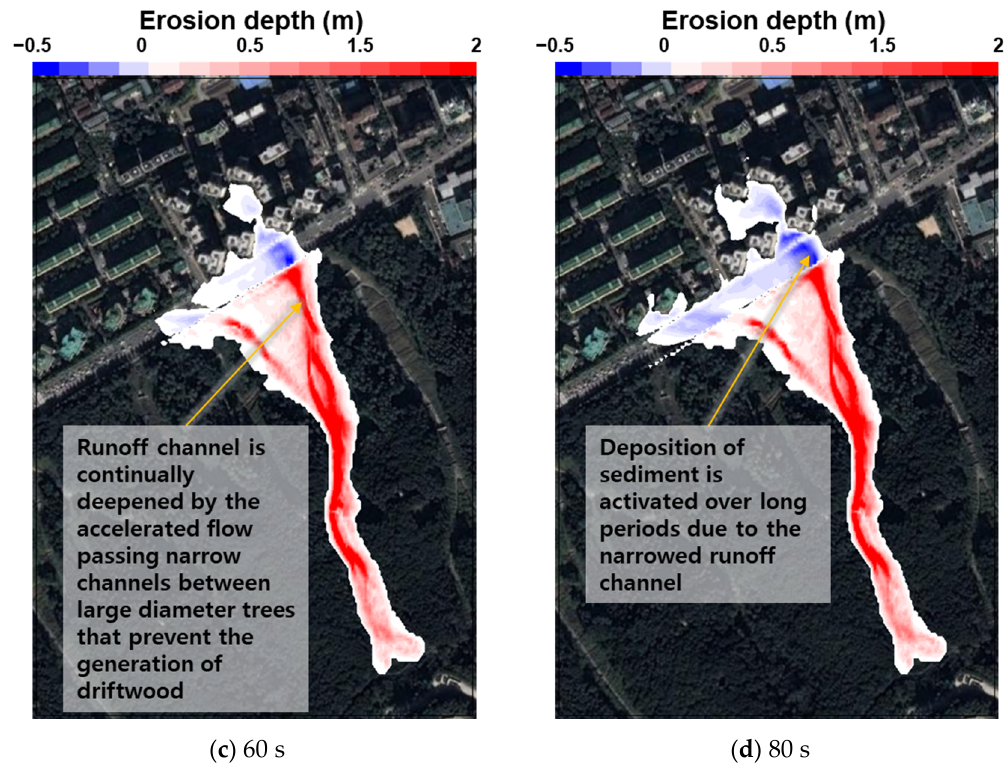
Figure 11. Time changes in entrainment erosion process of simulation (Run6).